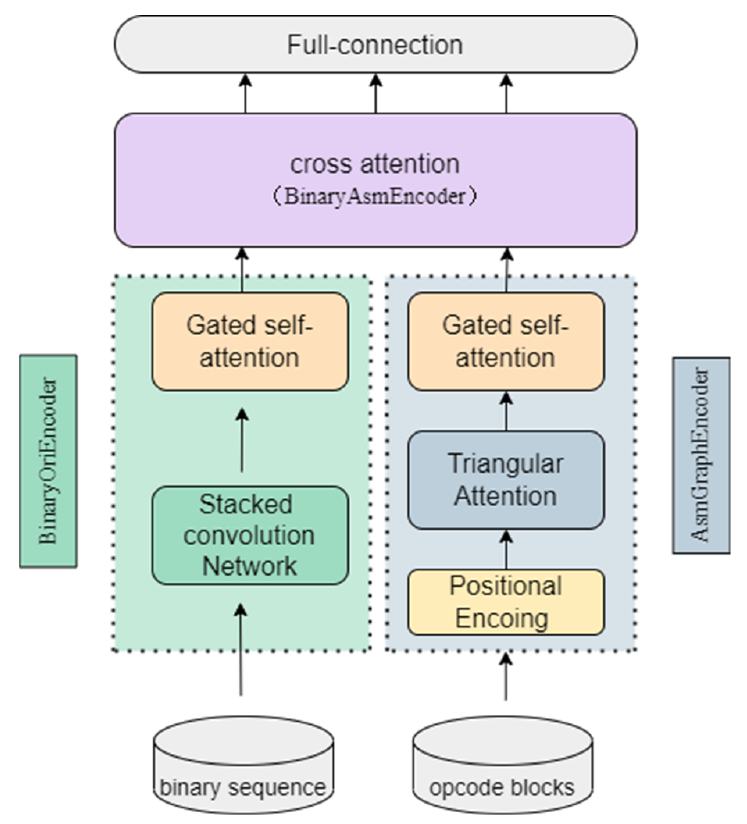
Figure 5. The model architecture for malware detection. Taking the sample with a length of 1,000 characters and number of code blocks of 20 as an example, the parameters used in each layer in the detection model are shown in Table